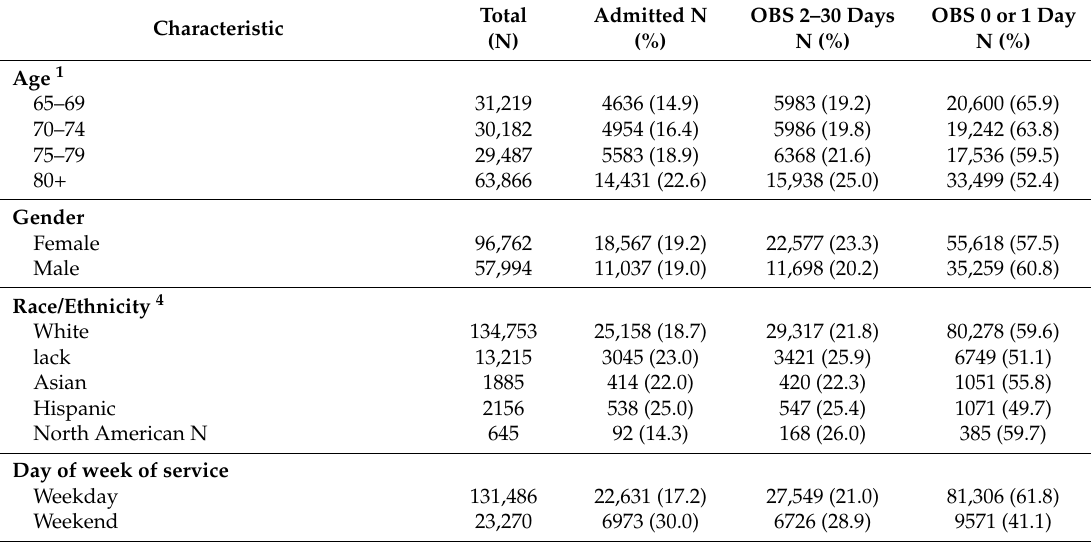
Table 1. Observation sample